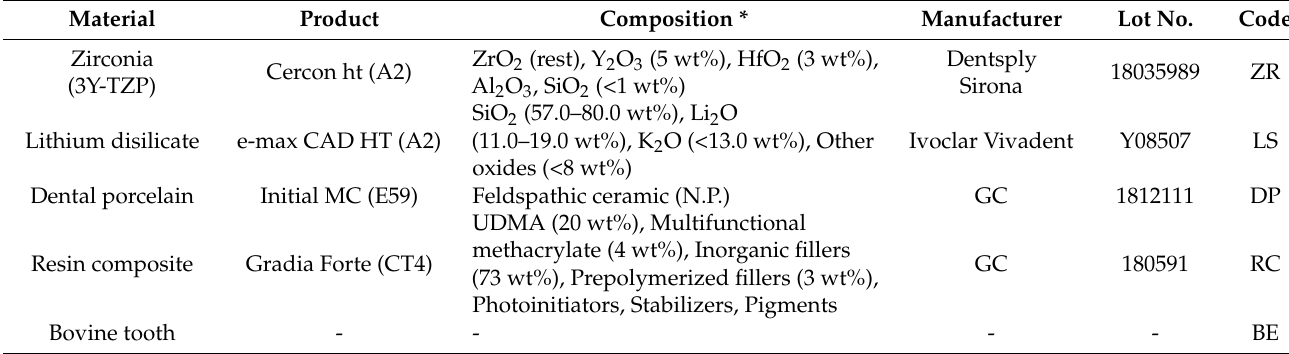
Table 1. Materials used as abrader specimens in this